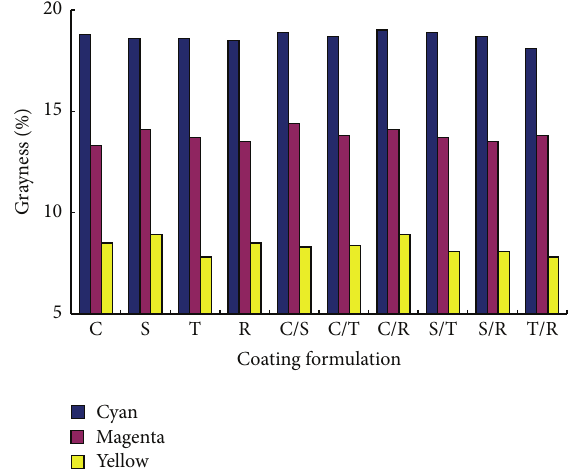
Figure 8: Effects of coating formulations on the print contrasts (PCs) of color inkjet-printed papers. C: CaCO 3 ; S: SiO 2 ; T: talc; R: sericite, with mixing ratios of 50/50.